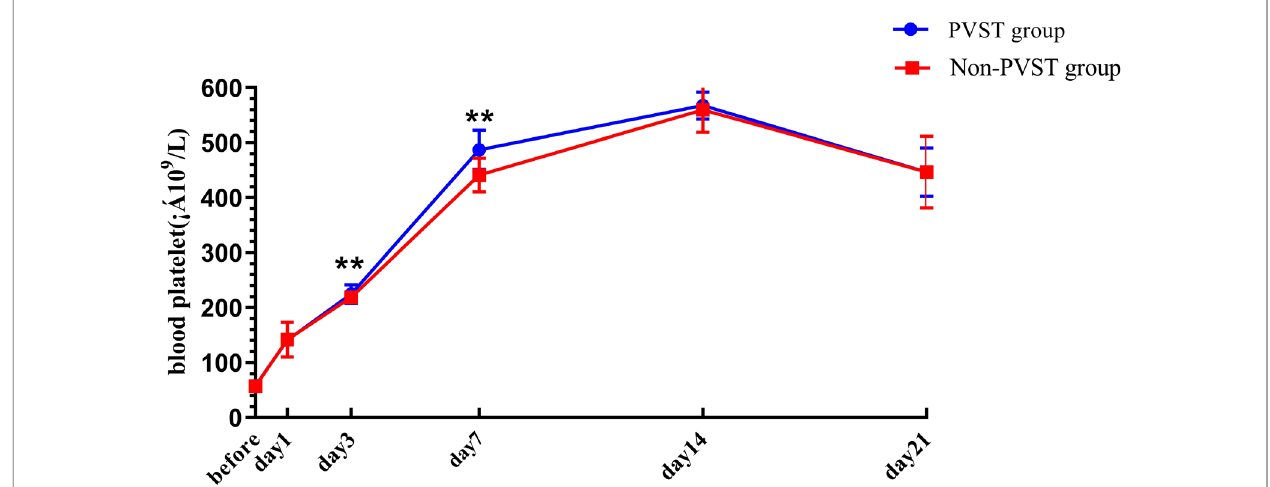
FIGURE 3 | The platelet changes in Wilson ’ s disease during the perioperative period after splenectomy in the PVST and non-PVST groups. The perioperative changes in plasma platelets in the PVST and non-PVST groups were observed at the 3rd and 7th days after surgery. Data were shown as mean±SD. F -all and P -all present the effect of interaction time and group from a repeated measurement linear model time points with differences between the two groups based on model-based pairwise comparisons as simple effects (Bonferroni). The symbol of “ ** ” indicates that the difference between the two groups is statistically signi fi cant ( Pp <0.01).